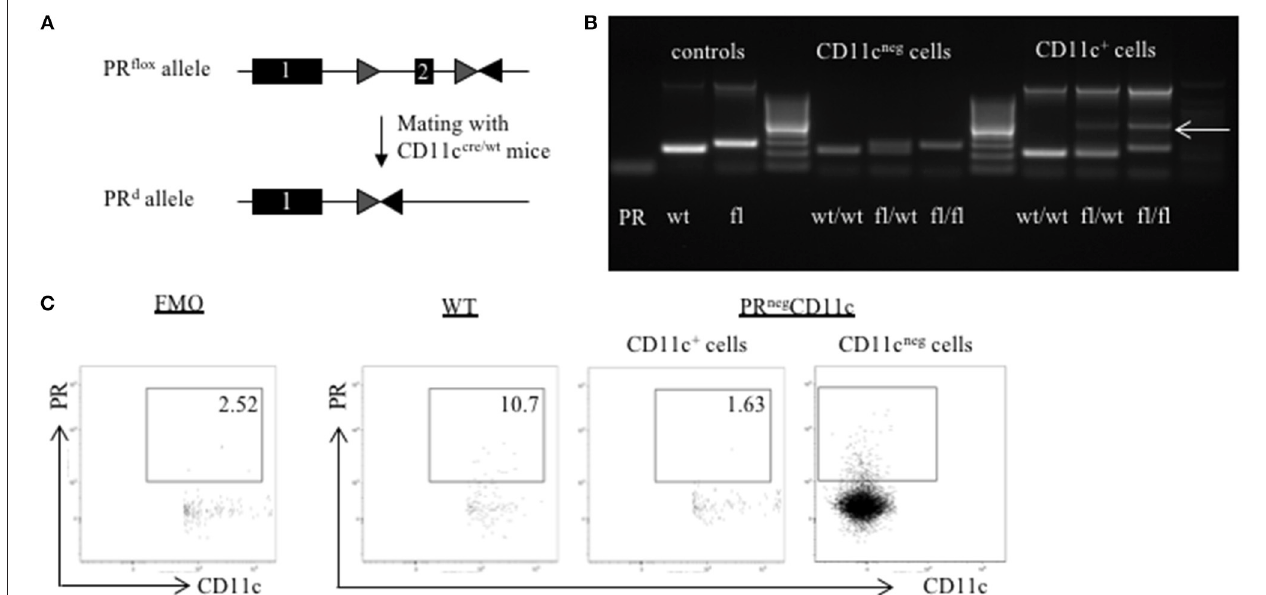
FIGURE 1 | Generation of a selective knockout (KO) of the progesterone receptor (PR) on CD11c dendritic cells (DCs): (A) PR flox / flox mice were crossed with CD11c cre / wt transgenic mice resulting in recombination of the PRflox allele to a PR null allele (PRd) on CD11c + cells. (B) The selective KO of the PR on CD11c + cells was confirmed on DNA level. PCR amplicons were visualized using agarose gel electrophoresis and band sizes were 226 bp for the wildtype allele, 260 bp for the floxed allele, and 381 bp for the KO allele, respectively. (C) The selective KO of the PR on CD11c + DCs harvested from WT and PR neg CD11c mice was confirmed on protein level by means of flow cytometry. The first dot plot on the left side is a fluorescence minus one (FMO) control for the PR